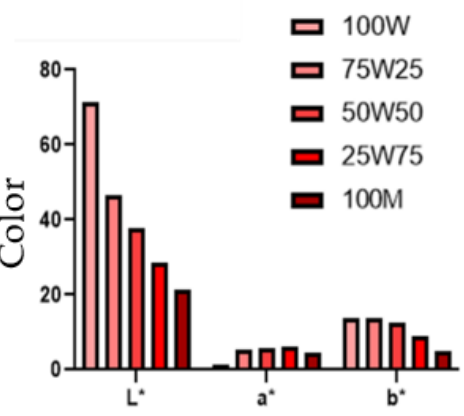
Figure 5. Color ( L* , a* , b*) of batter-coated shrimp with MPBP. 100W: 100% wheat flour, 75W25: Figure 5 . Color ( L*, a*, b*) of batter-coated shrimp with MPBP. 100W: 100% wheat flour, 75W25: 75% wheat flour and 25% MPBP, 50W50: 50% wheat flour and 50% MPBP, 25W75: 25% wheat flour and 75% MPBP, 100M: 100.